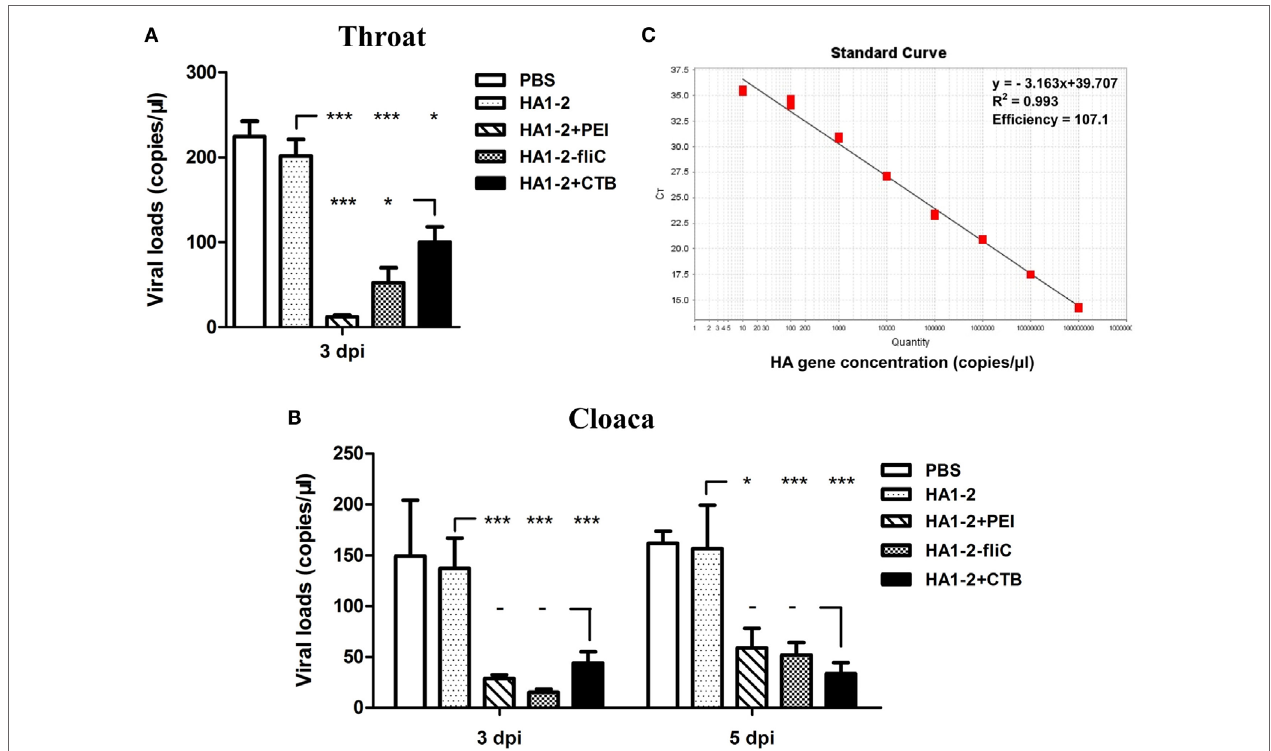
FigUre 8 | Viral loads detection in throat and cloaca following h7n9 virus challenge of vaccinated chickens . Two-week-old SPF chickens ( n = 8) were inoculated intranasally with 10 6 EID 50 of H7N9 influenza virus in a 200 μ l volume. The throat and cloaca swabs were collected from chickens and resuspended in 1 ml PBS for viral RNA extraction followed by real-time PCR (RT-PCR) for quantitative analysis of virus. (a) Viral loads in throat following H7N9 virus challenge at 3 dpi. (B) Viral loads in cloaca following H7N9 virus challenge at 3 and 5 dpi. (c) Standard curves (based on plasmid DNA) indicating the linearity and efficiency for detecting HA by